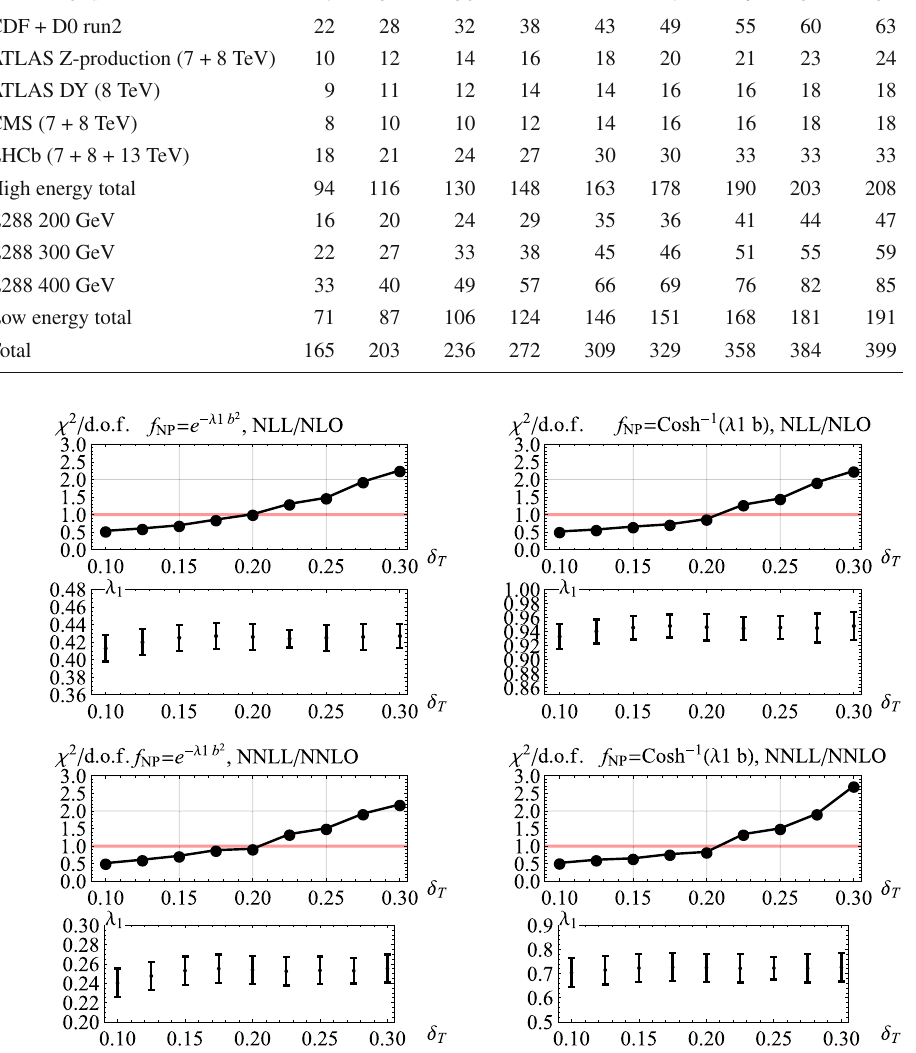
Table 10 The number of points with q T < δ T Q for each data set. In the majority of fits we use δ = 0 . 2, see explanation in the T